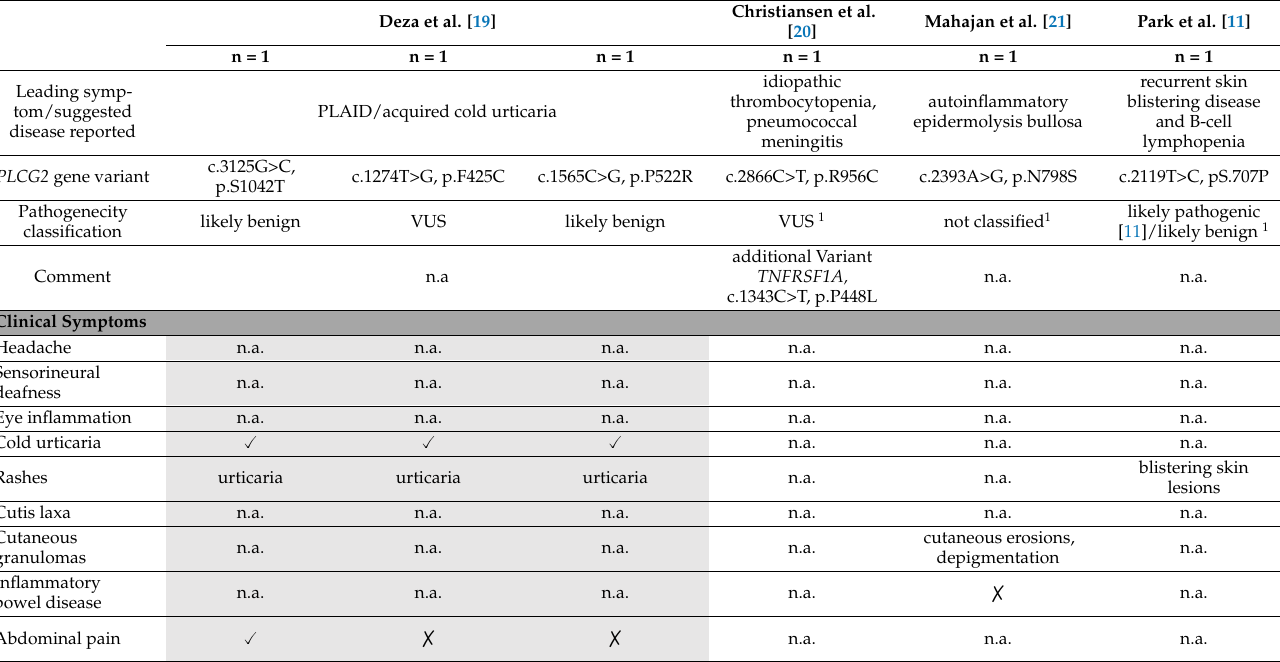
Table 1. Clinical and laboratory characteristics of patients with the heterozygous missense PLCG2 variant (c.77C>T, p.Thr26Met).